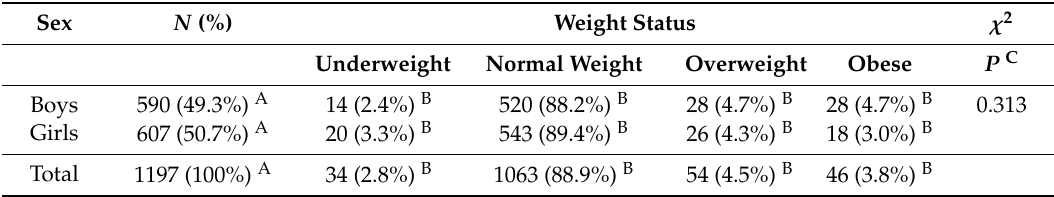
Table 2. Distribution of the sample according to the weight status of the